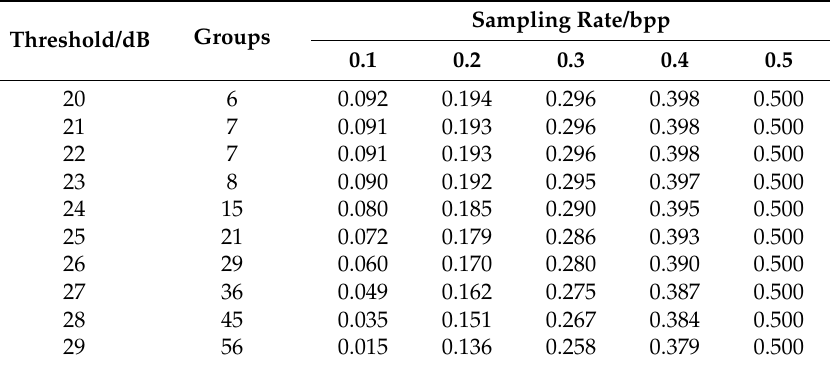
Table 1. Sampling rates of non-key bands in different groups.